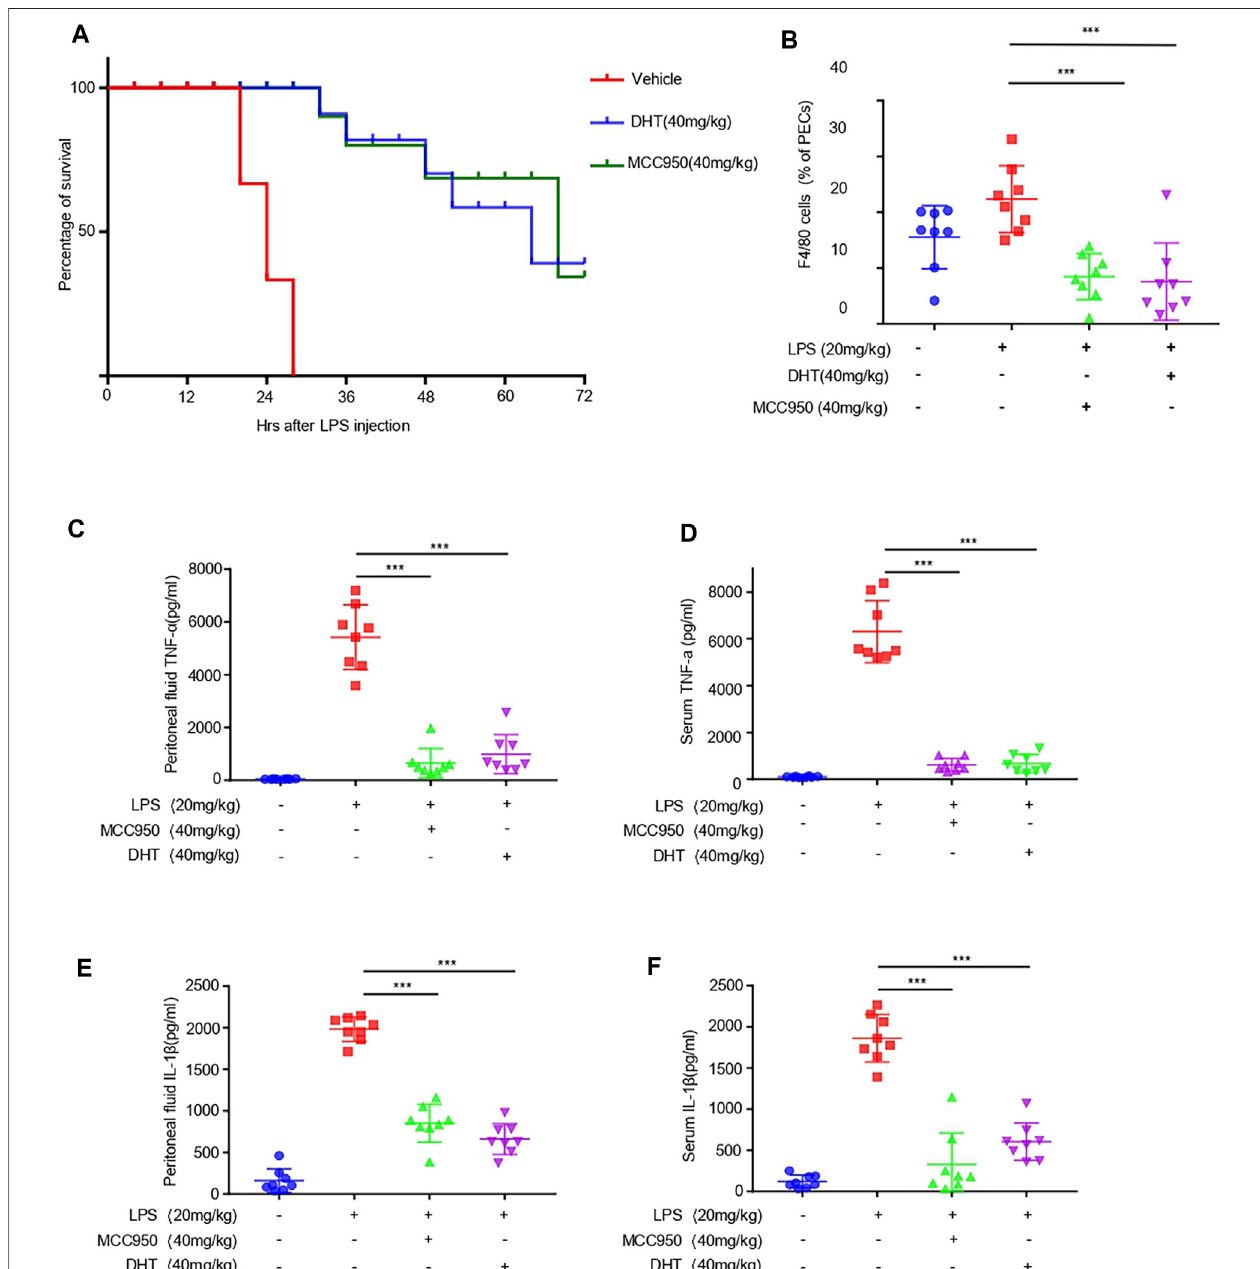
FIGURE5| DihydrotanshinoneIreducesLPS-inducedsepticshockandin fl ammation invivo . (A) Survivalrateofsepticshockinmice.Afterintraperitonealinjection ofDHT(40 mg/kg)andLPS(20 mg/kg),thelethalityof6-to8-week-oldC57BL/6femalemicewasmonitoredwithin72 h( n (cid:2) 10)(B – F)C57BL/6femalemiceweregiven vehicle control, DHT (40 mg/kg), or MCC950 (40 mg/kg) for 1 h and then treated with LPS (20 mg/kg) for 4 h. Monocytes-macrophages (F4/80 + cells) (B) , TNF- α (C) , IL-1 β (E) fromserumandTNF- α (D) ,andIL-1 β (F) intheperitoneallavage fl uidweremeasuredusing fl owcytometryandELISA.Dataarerepresentedasthemean ± SEM. Statistics differences were analyzed using an unpaired Student ’ s t -test * p < 0.05, ** p < 0.01, *** p < 0.001, NS: not signi fi cant.